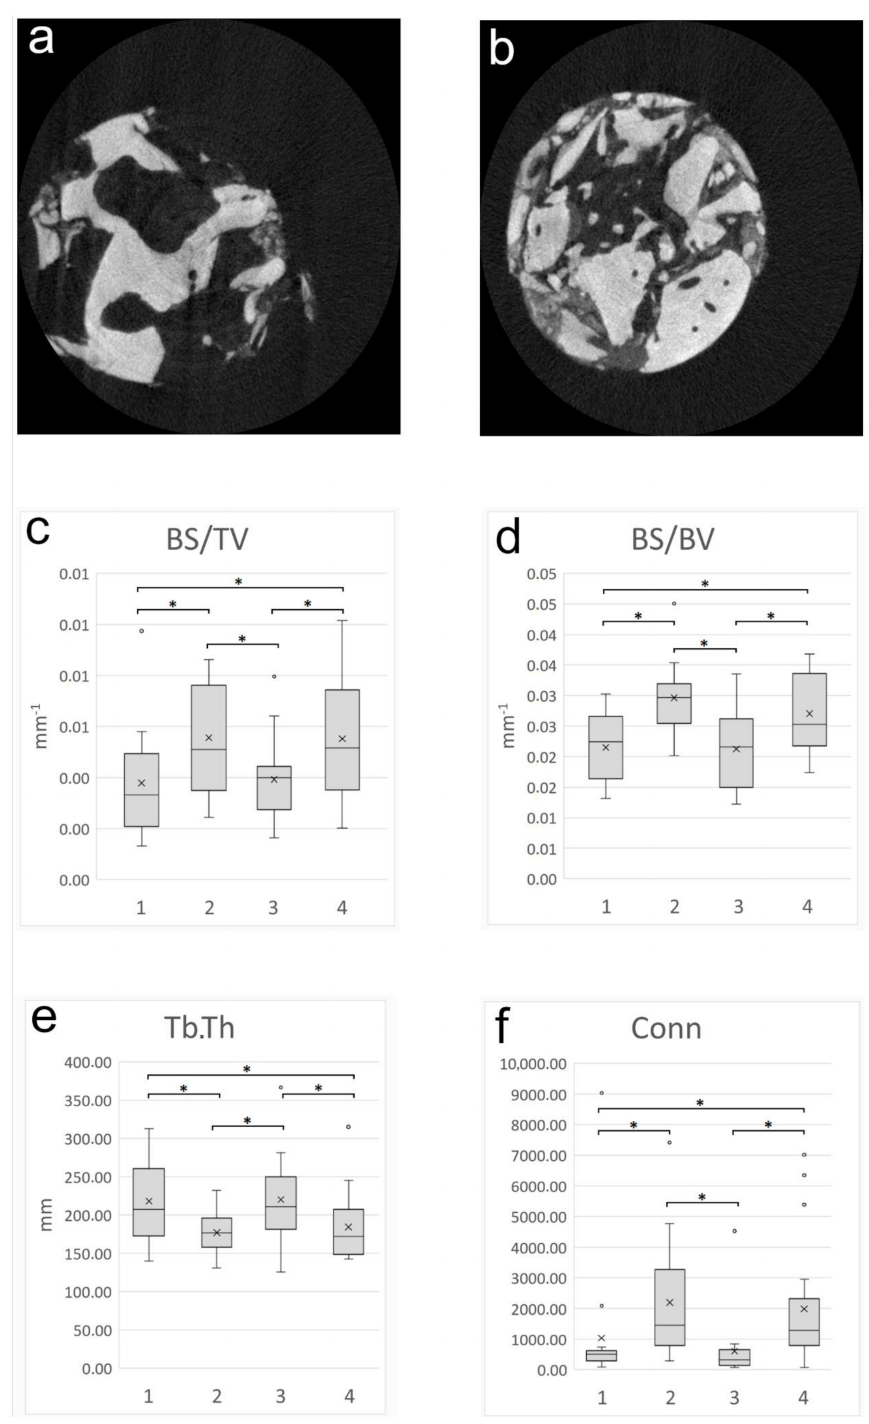
Figure 4. Representative µ CT images of the bone core biopsy samples are shown at the level of the pristine maxillary bone ( a ) and the level of the augmented bone ( b ) after 3 months of healing. Panels ( c – f ) show significant comparisons between the pristine maxil- lary bone and augmented bone based on micromorphometric data. Statistical significance ( p < 0.05) is marked by an asterisk. The following abbreviations were used: pristine bone in the 3-month healing group (1), augmented areas in the 3-month healing group (2), pristine bone in the 6-month healing group (3), augmented areas in the 6-month healing group (4), bone surface/volume ratio (BS/BV), bone surface density (BS/TV), trabecular thickness (Tb.Th) and the connectivity